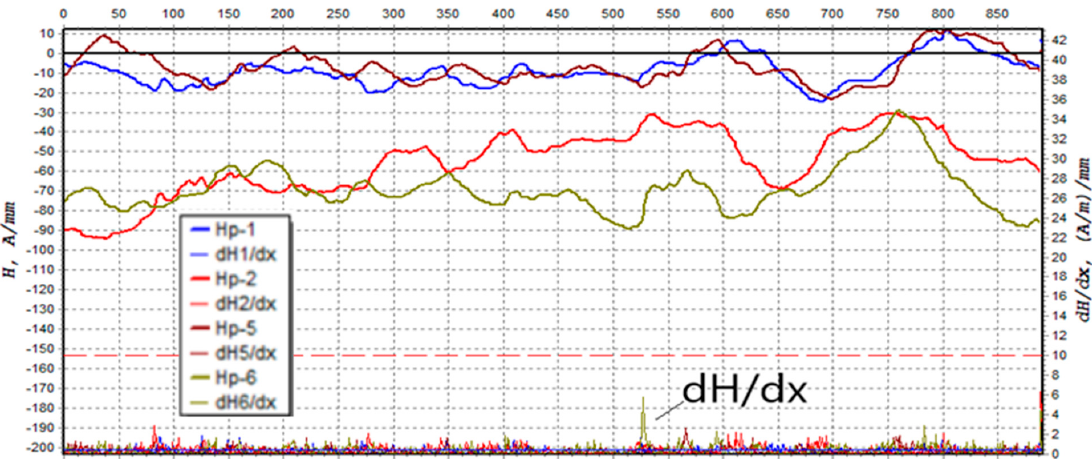
Figure 11. Distribution of the gradient dH / dx tangent component of magnetic field.